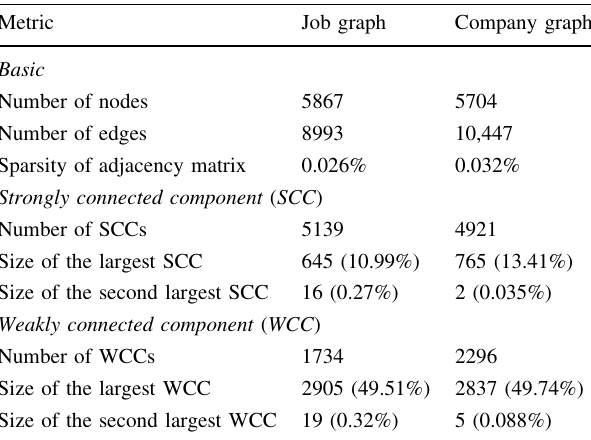
Table 8 Network statistics of the Switzerland dataset